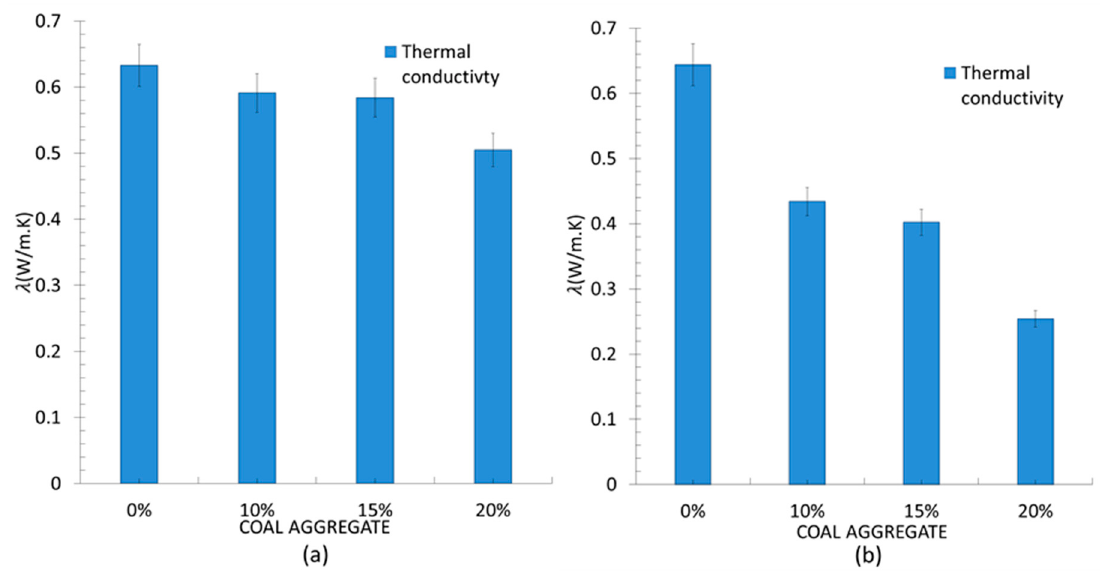
Figure 11. Thermal conductivity results of sample bricks in the function of CA percentage: ( a ) without lime, ( b ) with 4% of lime.